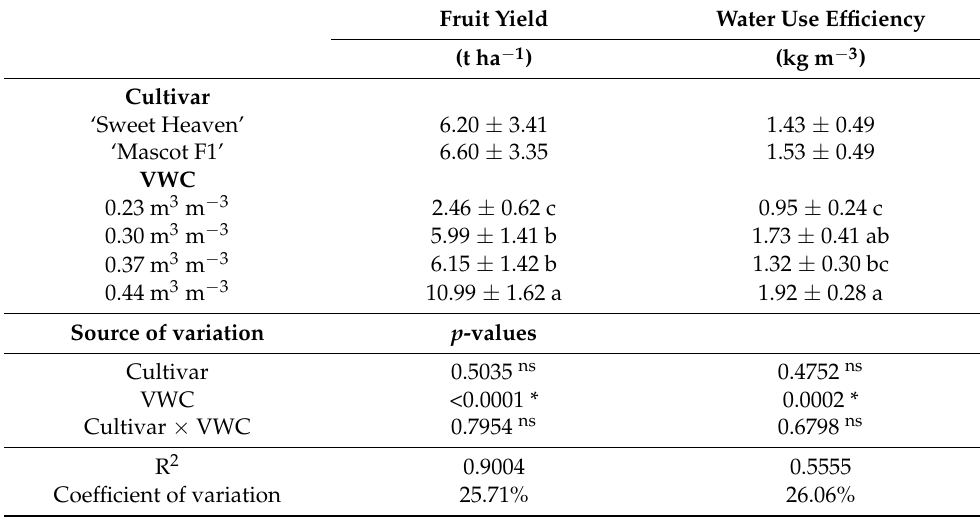
Table 3. Fruit yield and water use efficiency of two cherry tomato cultivars in response to increasing volumetric water contents